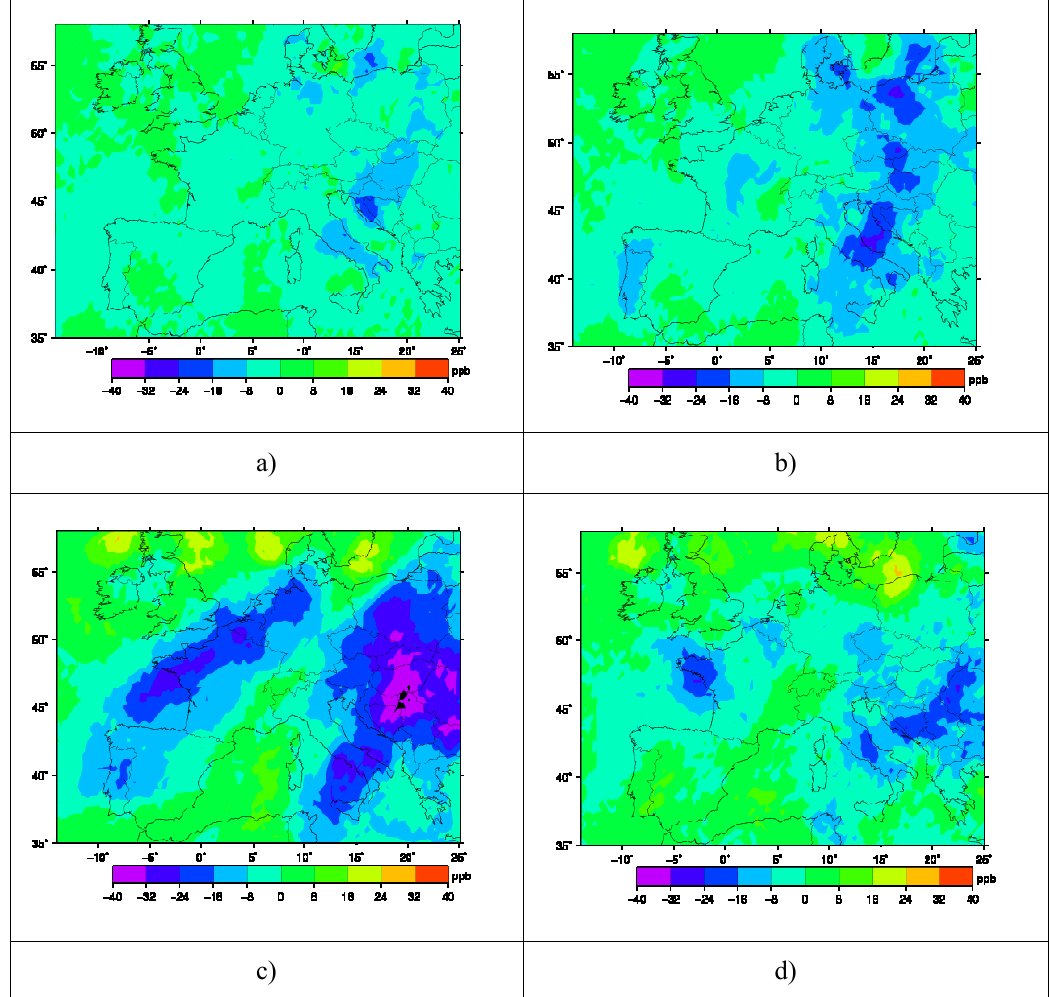
Fig. 8. 2-dimensional maps with corrections performed at various altitudes for 17 July 2007. The four contour plots are the corrections (concentration after assimilation minus concentration before assimilation) at (a) surface, (b) 1km, (c) 5km and (d) 9km altitude. The ozone concentrations are expressed in ppb (color scale varies from violet representing relatively low values, to red representing relatively high values and the min/max values are − 40/40 ppb).